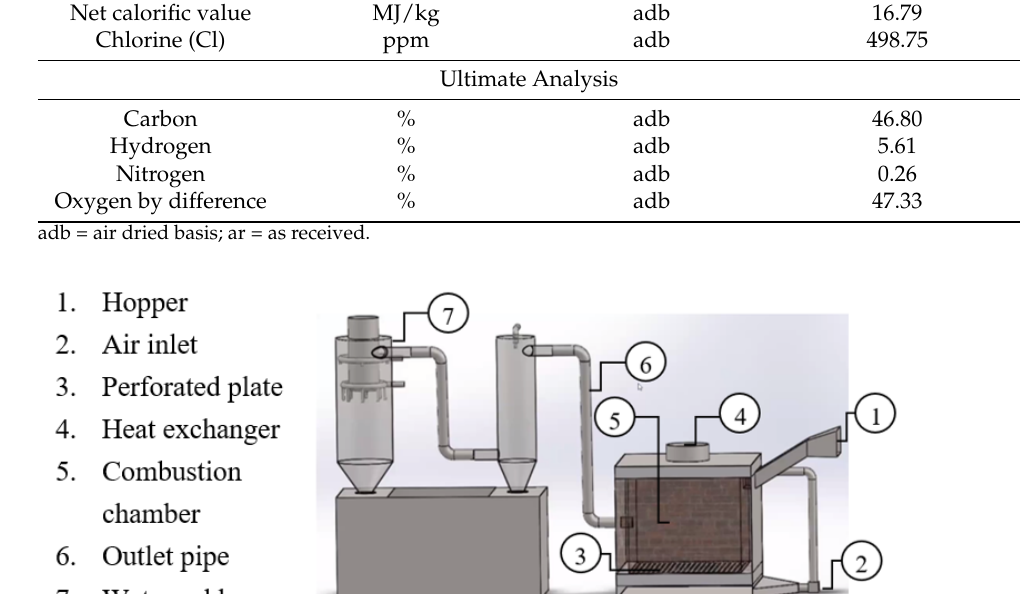
Figure 2. Experimental scheme for a biomass pellet furnace.